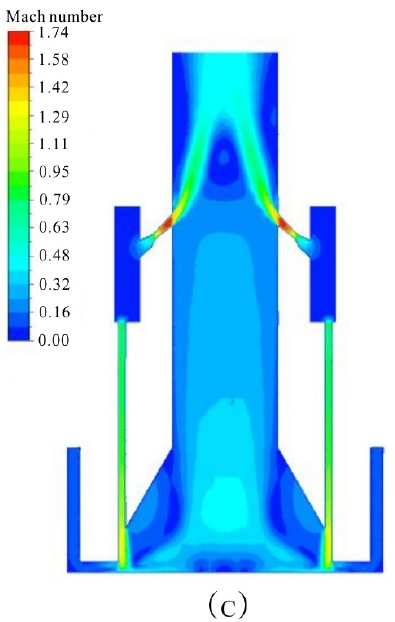
Figure 9. Schematic view within the reverse ‐ circulation bit based on the contours of the Mach number: ( a ) θ = 24°; ( b ) θ = 32°; and ( c ) θ = 48°.